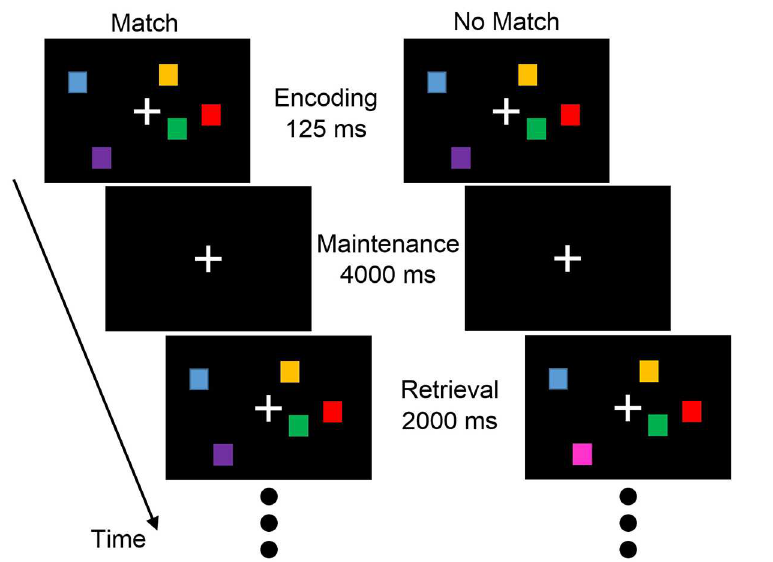
Fig 2. Delayed match-to-sample visuospatial working memory